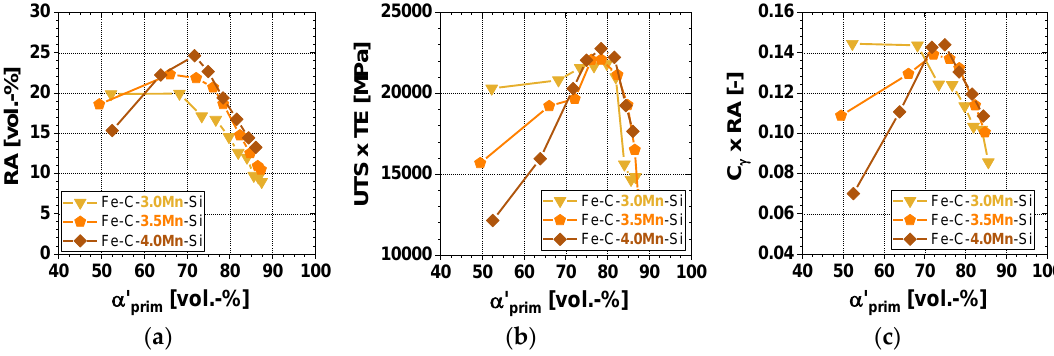
Figure 12. ( a ) RA-content, ( b ) UTS × TE and ( c ) C γ × RA as a function of α’ prim for the investigated steels.